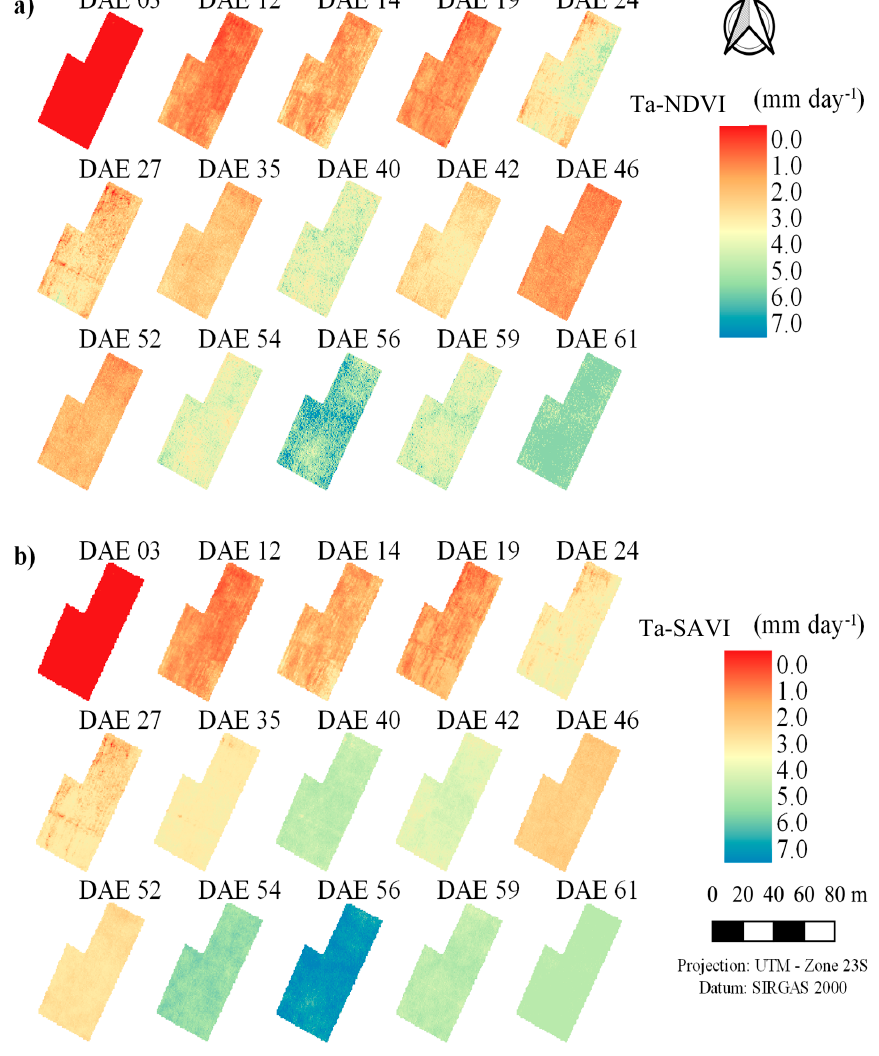
Figure 5. Actual transpiration of maize crop determined by the methodologies derived from NDVI ( a ) and SAVI ( b ).